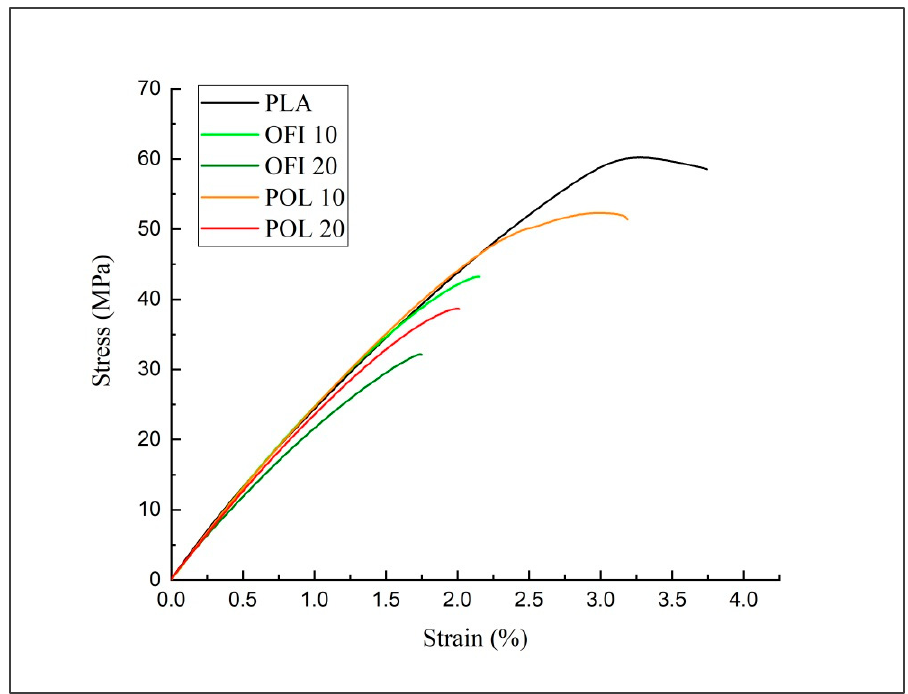
Figure 12. Stress–strain curves of the investigated systems (tensile tests).